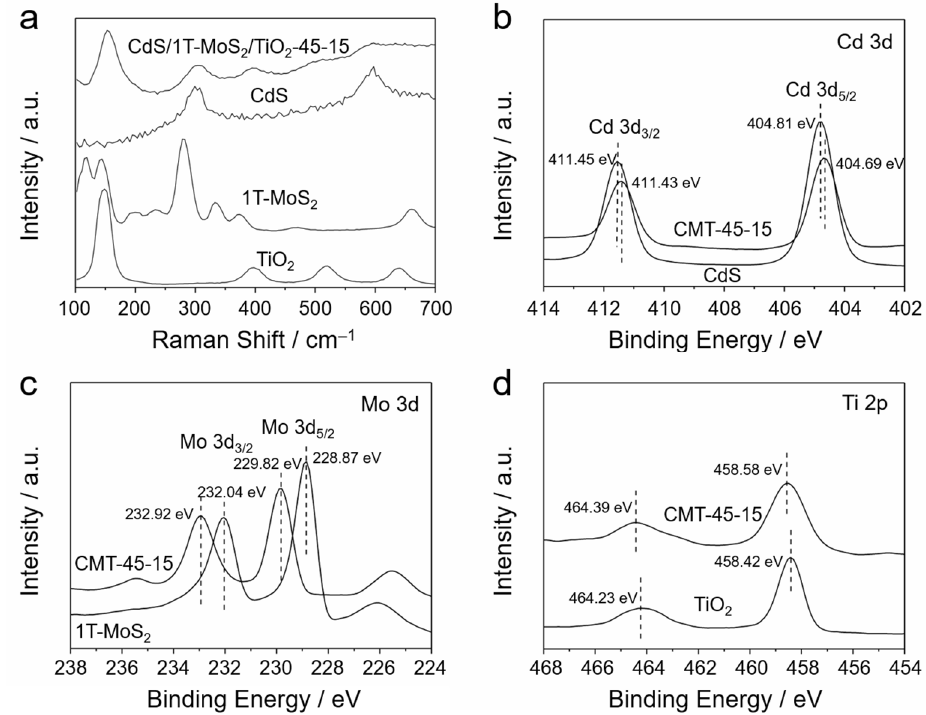
Figure 3. ( a ) Raman spectra of the bare CdS, TiO 2 , and CdS/1T-MoS 2 /TiO 2 -45-15 samples. High resolution XPS spectra of ( b ) Cd 3d in bare CdS and CdS/1T-MoS 2 /TiO 2 -45-15; ( c ) Mo 3d in 1T-MoS 2 and CdS/1T-MoS 2 /TiO 2 -45-15; ( d ) Ti 2p in TiO 2 and CdS/1T-MoS 2 /TiO 2 -45-15(CMT-45-15).